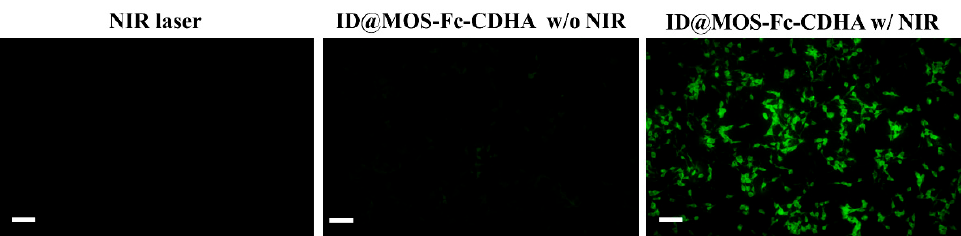
Figure 6. Detection of the intracellular ROS in the B16F10 melanoma cells treated with the ID@MOS- μ Fc-CDHA nanocomposites with (w/) or without (w/o) the NIR laser irradiation. Scale bars are 50 μ m.